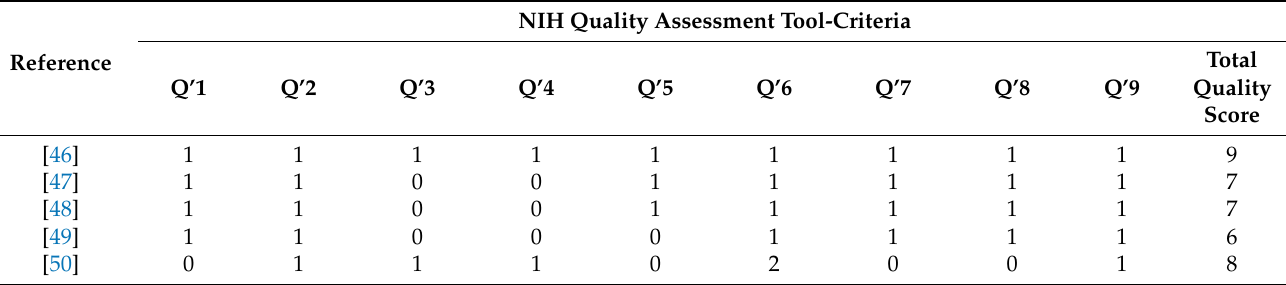
Table 10. Assessment of methodological quality of case series/case reports (type: Case studies), according to the adapted NIH quality assessment tool